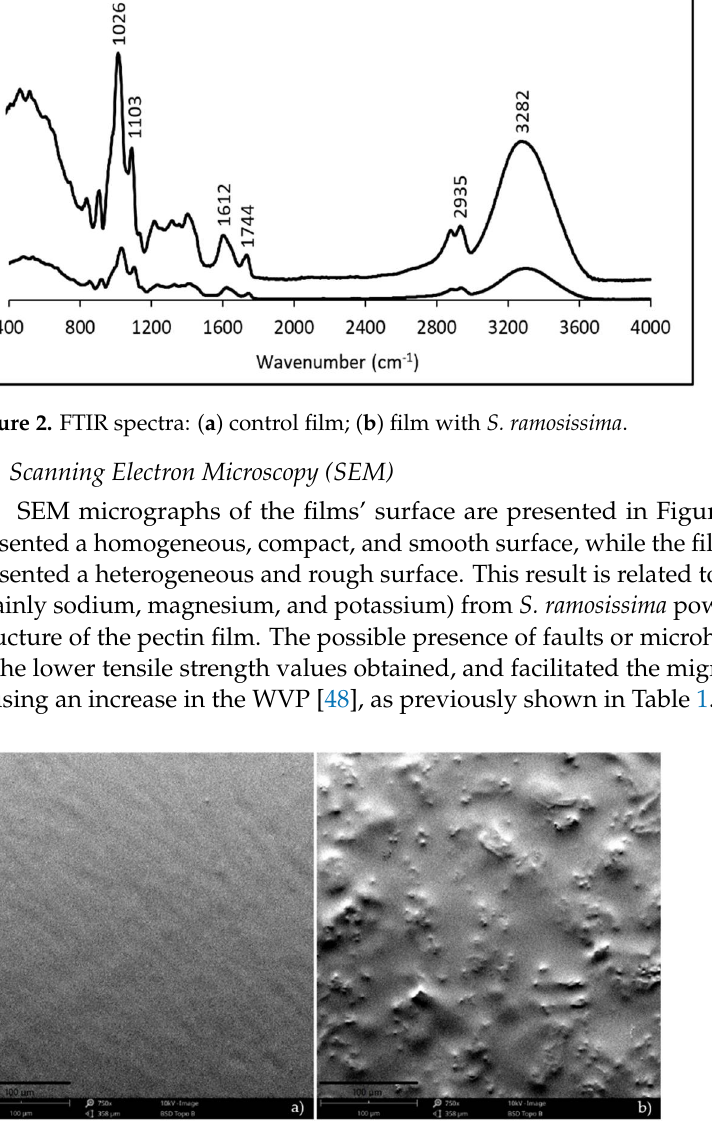
Figure 3. SEM micrographs: ( a ) control film; ( b ) film with S. ramosissima (scale bar = 100 µm).